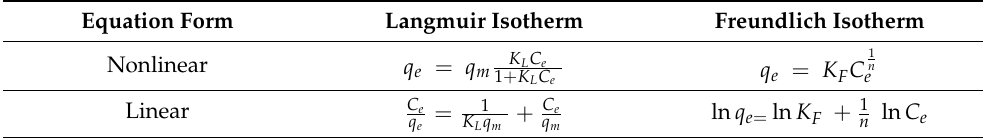
Table 3. Nonlinear and linear forms of the Langmuir and Freundlich isotherms.